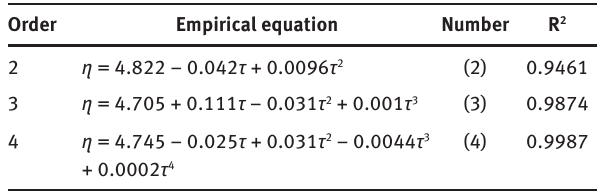
Table 4: The empirical equation of kinematic viscosity and oxidation time of Jatropha curcas biodiesel at 25°C